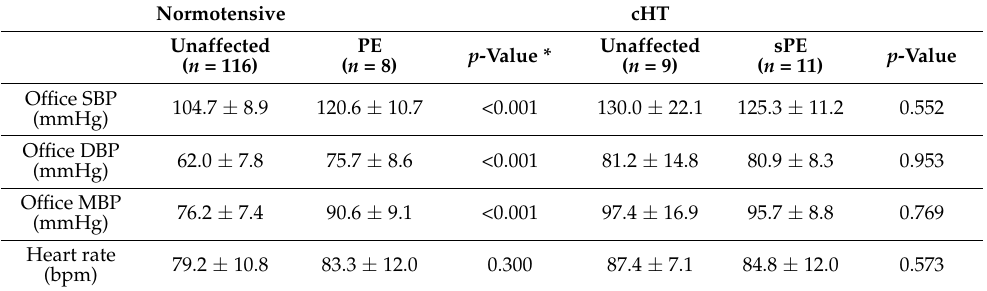
Table 3. Office blood pressure values in the first trimester in normotensive and chronic hypertensive pregnant women.